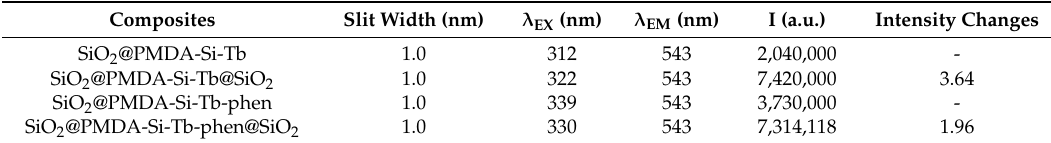
Table 1. Photoluminescence emission spectra data of the Tb(III) core-shell and core-shell-shell